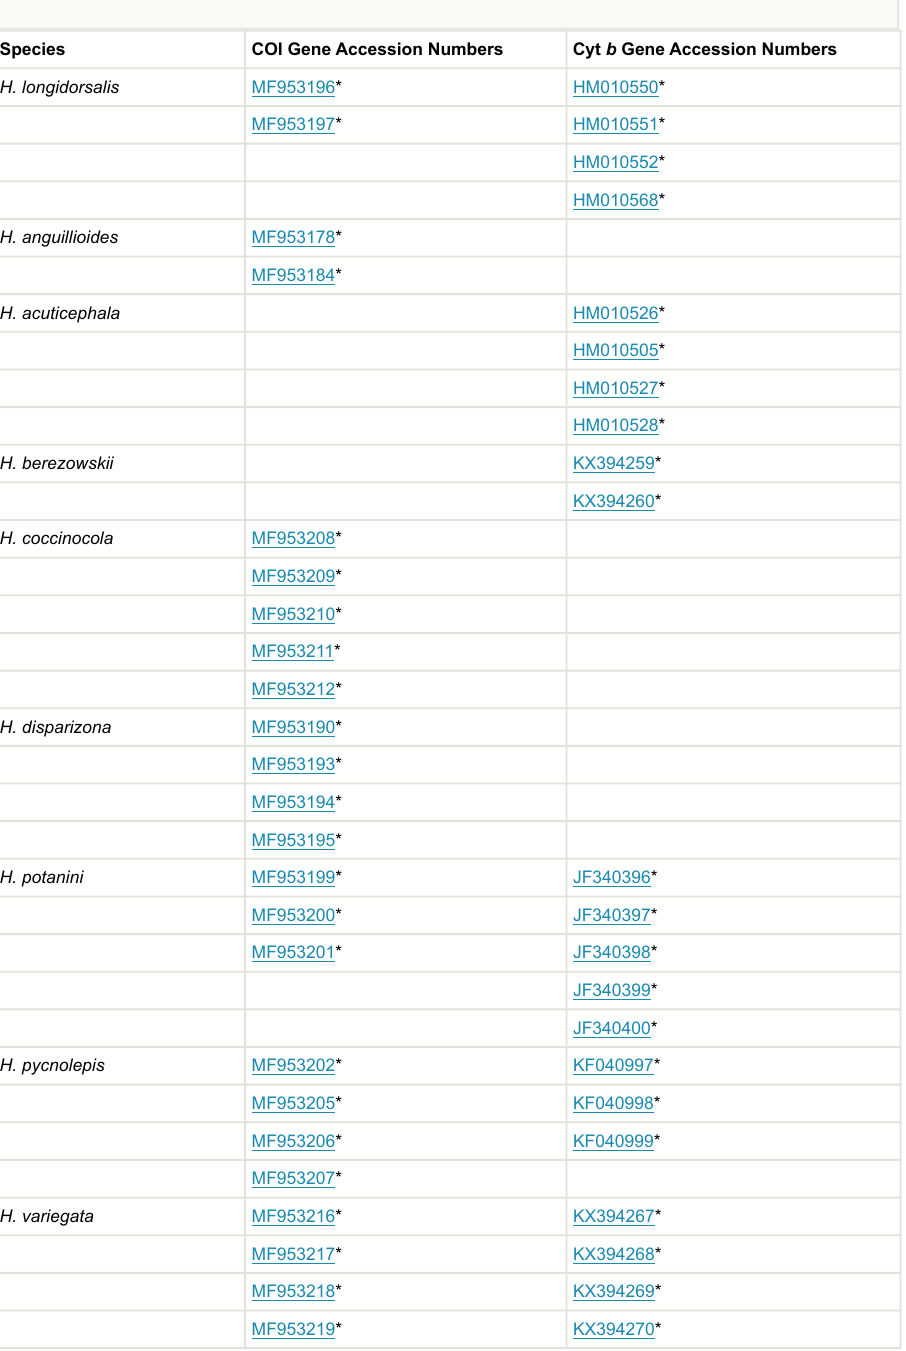
Table 1. GenBank accession numbers of COI and Cyt b